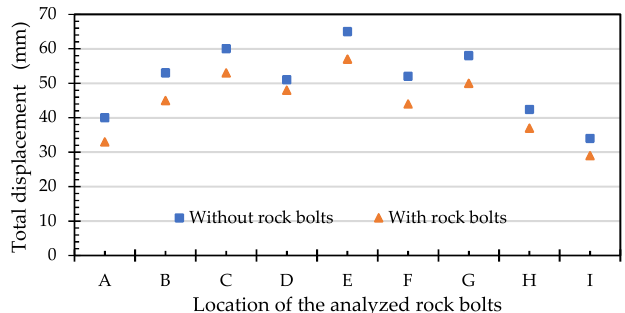
Figure 30. Total displacement without rock bolts and with rock bolts alone.